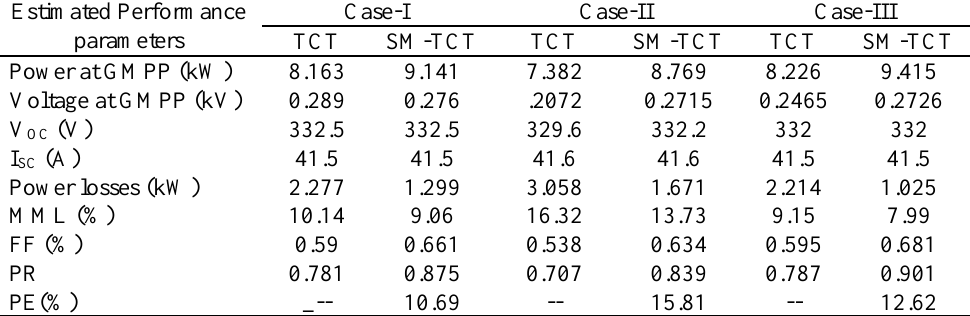
Table 2. Performance parameters f proposed